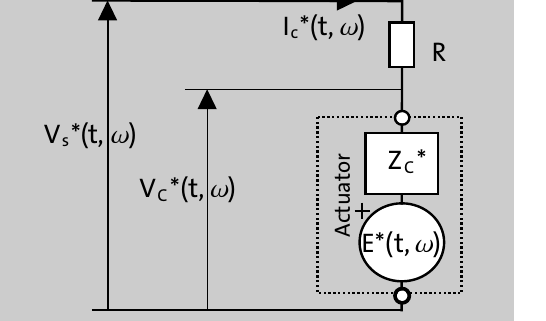
Figure 1 (left ): Circuit diagram of an electromagnetic actuator. Figure 2 (right): Block diagram of an electromagnetic